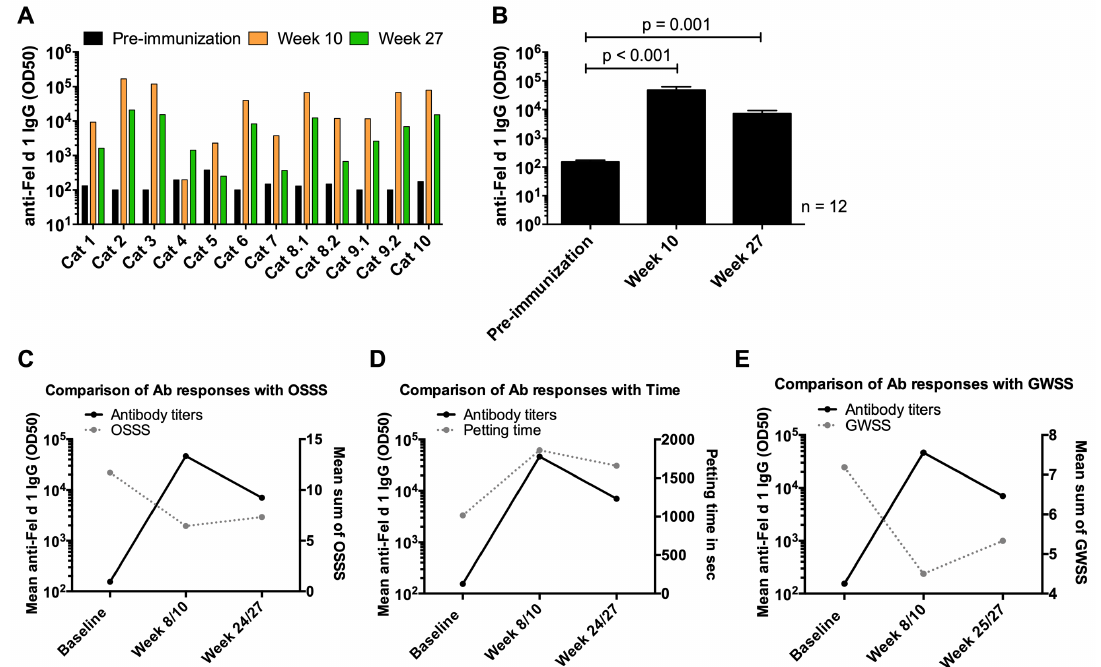
Figure 5. Antibody responses in cat sera. ( A ) Anti-Fel d 1 IgG antibody titers in cats before and after immunization, n = 12. ( B ) Mean anti-Fel d 1 IgG antibody titers with SEM, n = 12. ( C ) Anti-Fel d 1 IgG antibody titers in cats at baseline (before immunization), week 10 and 27 vs. OSSS at corresponding timepoints baseline (before immunization), week 8 and 24. ( D ) Anti-Fel d 1 IgG antibody titers in cats at baseline (before immunization), week 10 and 27 vs. petting time at corresponding timepoints baseline (before immunization), week 8 and 24. ( E ) Anti-Fel d 1 IgG antibody titers in cats at baseline (before immunization), week 10 and 27 vs. GWSS at corresponding timepoints baseline (before immunization), week 8 and 25. (C-E) Data included from participants ( n = 9) with corresponding study cats ( n = 9). Statistical significances were obtained by an exact Wilcoxon matched-paired signed rank